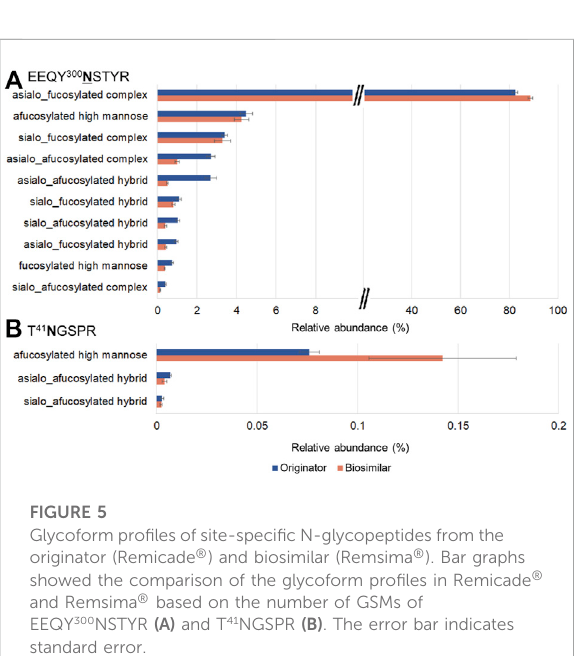
FIGURE 5 Glycoform pro fi les of site-speci fi c N-glycopeptides from the originator (Remicade ® ) and biosimilar (Remsima ® ). Bar graphs showed the comparison of the glycoform pro fi les in Remicade ® and Remsima ® based on the number of GSMs of EEQY 300 NSTYR (A) and T 41 NGSPR (B) . The error bar indicates standard